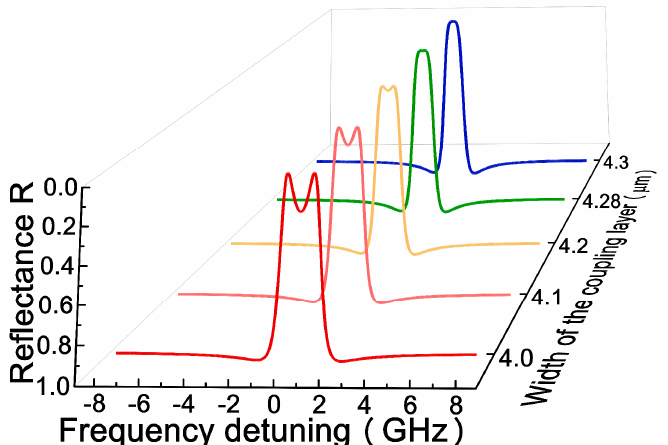
Figure 3. Evolution of the real (Re ( ∆ ω ) , ( a )) and imaginary (Im ( ∆ ω ) ( b )) parts of the eigenvalues as the coupling strength increases.